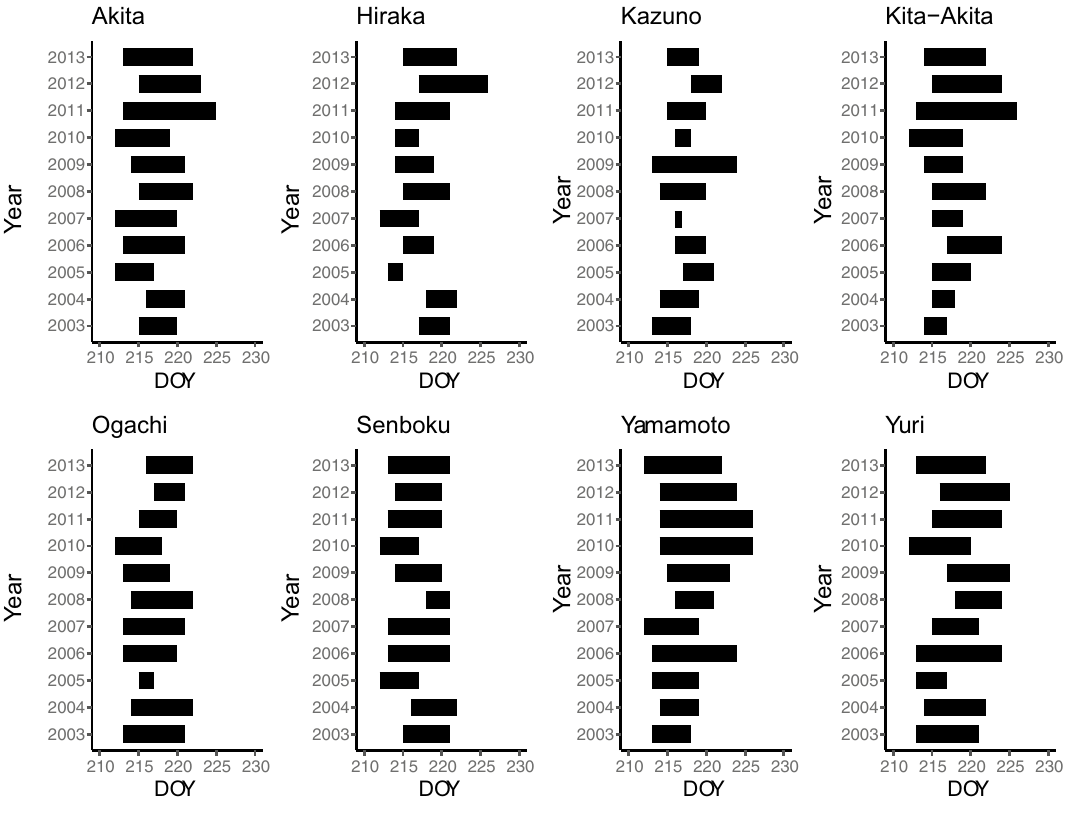
Figure 2. The term of the rice ear emergence date according to the region and year. X axis indicates DOY means “Day of Year” which is continuous number from 1 (1, Jan) to 365 or 366 (31, Dec). The length of each bar indicates the range from the earliest to the latest ear emergence dates in each region in each year.